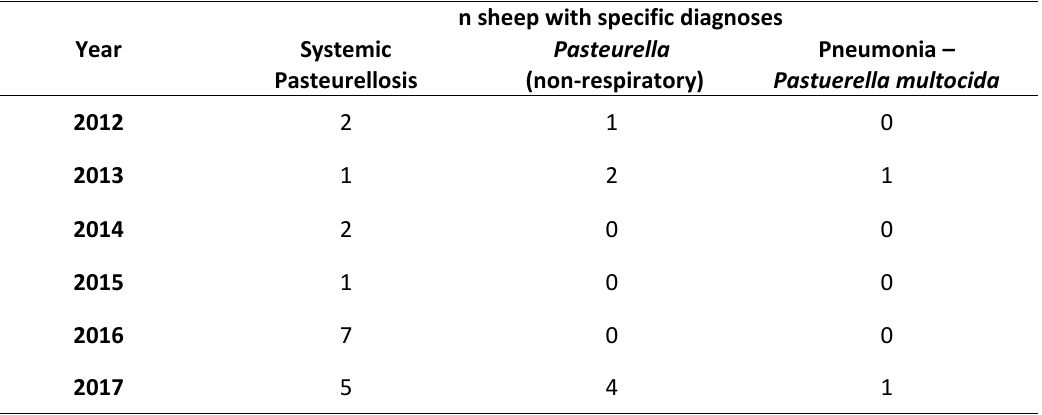
Table S1 Sheep Surveillance Dashboard 2012–2017 data for number of sheep in Devon submitted for necropsy to the regional Animal Plant and Health Agency (APHA) veterinary investigation centre in which Pasteurella spp . were diagnosed as cause of